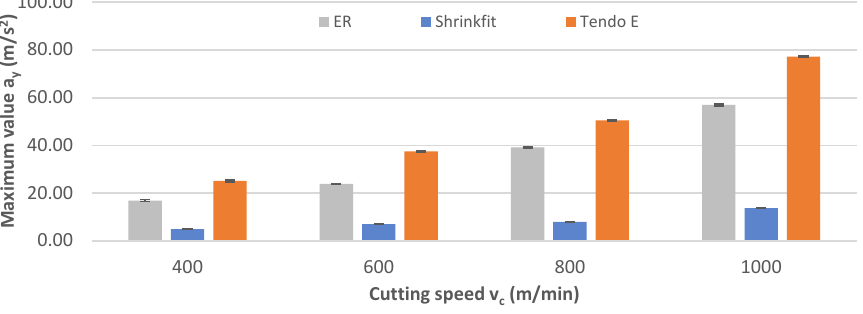
Figure 12. Impact of cutting speed v c on the maximum vibration acceleration value a y (f z = 0.15 mm/tooth, a p = 6 mm).